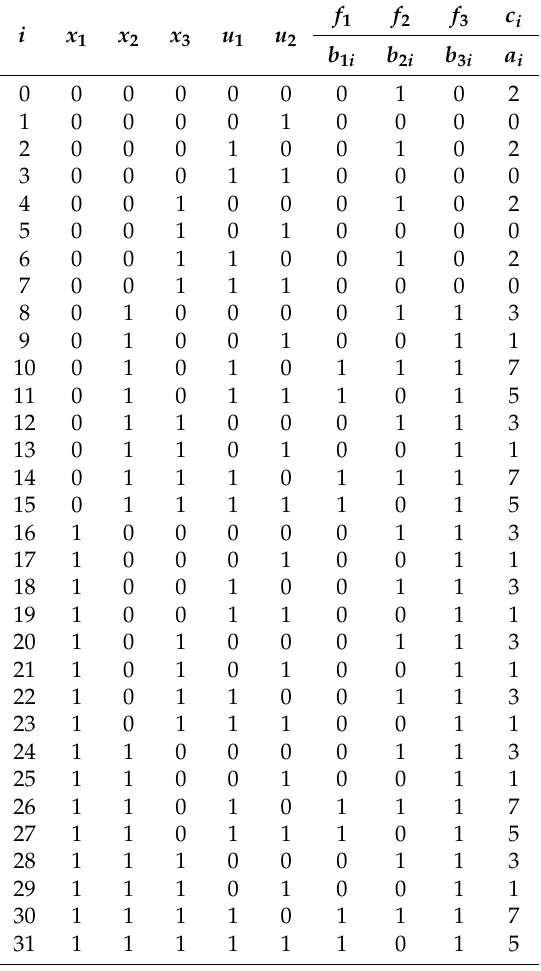
Table 1. Truth table relative to N in (The indexed parameters a and b given together with other parameters are needed only further for Algorithm 2).